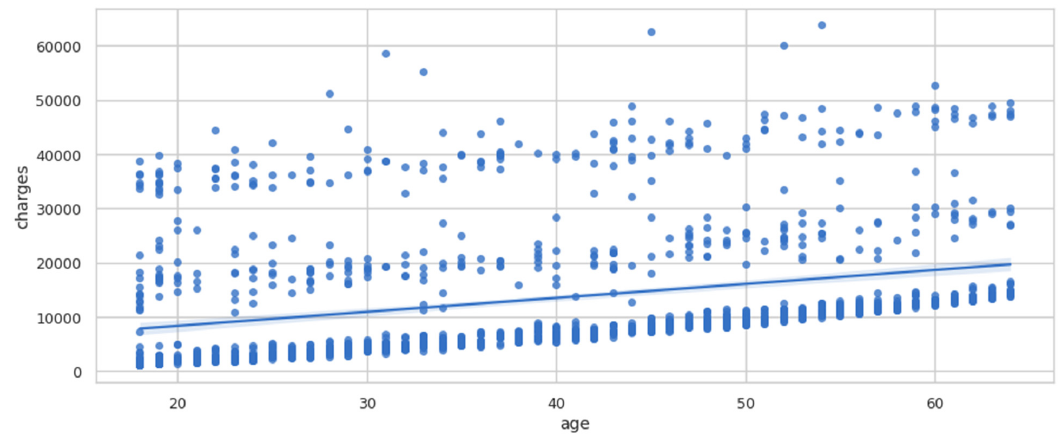
Figure 5. Regplot of charges vs. age.